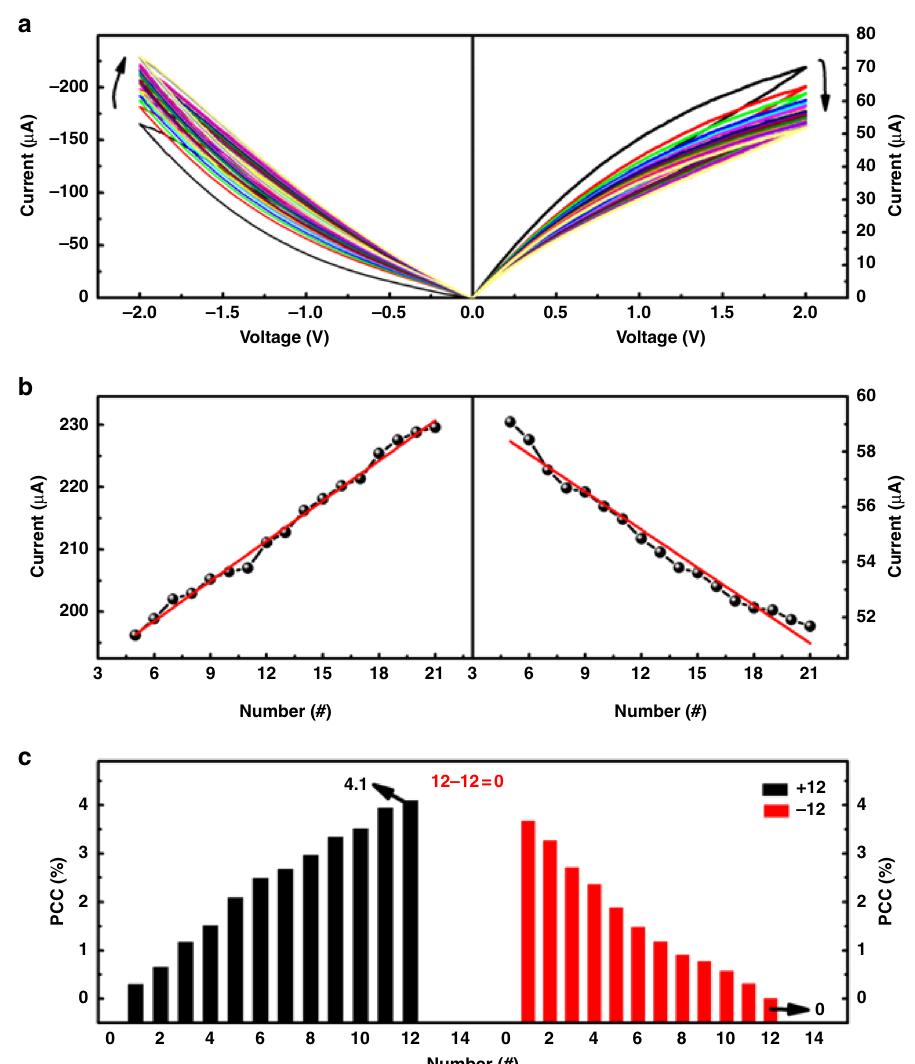
Fig. 5 Consecutive memristive switching characteristics in low resistance state. a Current – voltage curves of the ITO/PFTPA-Fc/Pt device. b Linear relationship between the device currents read at ± 2 V and voltage sweeping numbers. c Calibration of the PFTPA-Fc memristor with the operation of 12 – 12 = 0 for decimal arithmetic